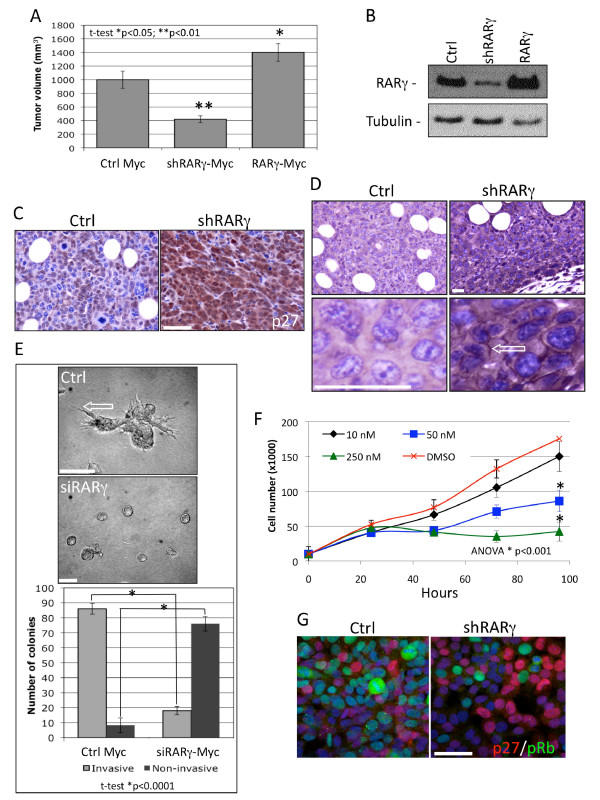
Retinoic acid receptor (RAR)γ modulates tumor cell growth, differentiation and morphology in MMTV-Myc xenografts in FVB mice. A) Primary cells from MMTV-Myc tumors were isolated and cultured. They were then transfected with the control vector pSG5 or a vector tethered to shRARγ or pSG5-RARγ, shRARγ or pSG5-RARγ plasmids. Transfected cells (0.5 × 106) were inoculated orthotopically into the abdominal mammary gland fat pad (gland number 4) of 10 FVB female mice, whereas their contralateral fat pad was inoculated with pSG5-transfected cells to serve as an internal control. Tumor volume shown is after 15 days of in vivo growth. Results shown are representative of two independent experiments. B) Immunoblotting of tumor cell lysates with anti-RARγ antibody showing the levels of RARγ in the shRARγ and pSG5-RARγ-transfected Myc cells. Immunohistochemical analysis of five sections per group of tumors derived from the shRARγ-transfected cells compared to the vector control cells (C and D). C) Expression of cell growth-arrest marker p27 (brown); space bar = 100 um. D) Expression of differentiation marker E-cadherin. Plasma membrane-associated E-cadherin was detected in the shRARγ tumors (open arrow); space bar = 20 um. E) Morphologic analysis of Myc cells cultured under three-dimensional conditions in Matrigel® (4 wells/group); bar = 100 μm. The number of colonies exhibiting the invasive (t-test P < 0.0001, light-gray bars) and noninvasive (t-test P < 0.0001, dark-gray bars) phenotype was quantified. F) RARγ antagonist SR11253 inhibits Myc tumor cell proliferation in a dose-dependent manner. Proliferating Myc cells were treated with increasing concentrations of SR11253 as shown. G) Confocal immunofluorescence for p27 (cell arrest marker, red) and pRB (proliferation marker, green) in Myc cells transfected with the shRARγ construct and in vector alone-transfected control cells; bar = 50 μm. Panels E, F and G are representative of three independent experiments.